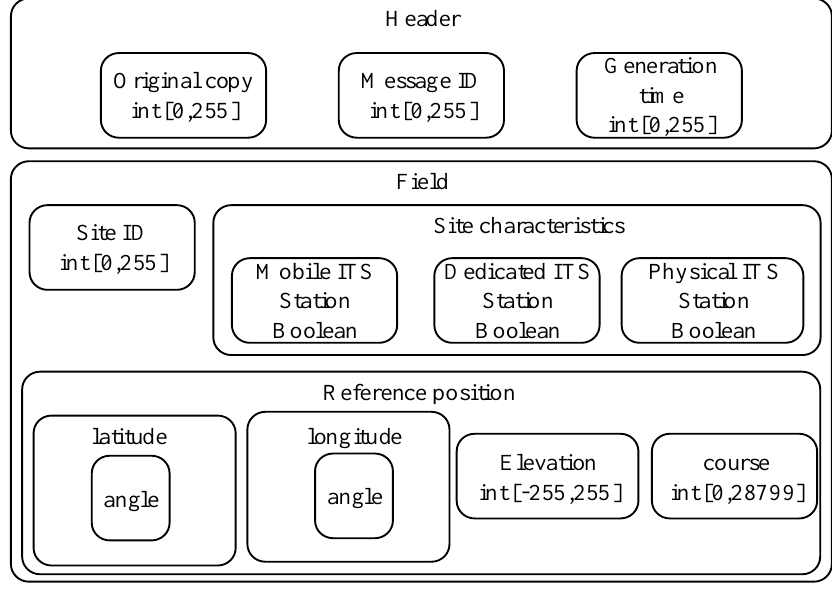
Figure 2. Cooperative awareness message (CAM) data format.